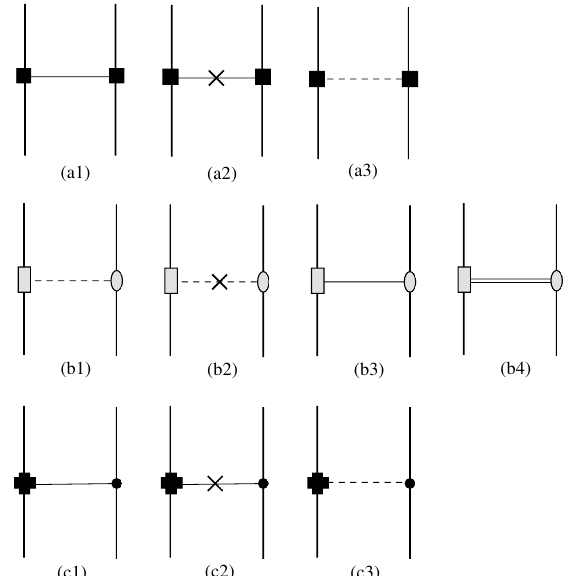
Figure 2 . The Feynman graphs of one-graviton exchange, that contribute to the NLO quartic-in- spin interaction at the 5PN order for maximally-rotating compact objects. At the linear level we only have three types of interaction, similar to the LO in [28], of either a quadrupole-quadrupole, octupole-dipole or a hexadecapole-monopole type. The graphs are easily constructed following the nice analogies pointed out in [28] among the interactions according to the parity of the multipole moments involved. Notice that we have here the three graphs that appeared at the LO with the quadratic time insertions on the propagators at graphs (a2), (b2), (c2), and a new hexadecapole coupling with the KK vector field at graph